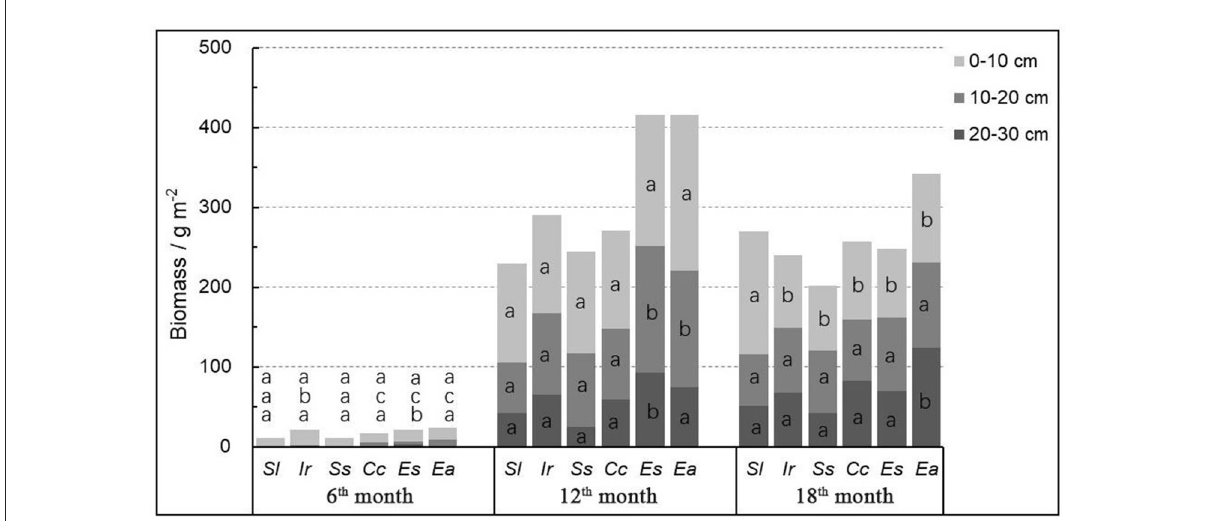
FIGURE4 Vertical development of fine root biomass (g m − 2 ) of all the six tree species from the 6 to 18th month since plantation. The abbreviations of Sl , Ir , Ss , Cc , Es , and Ea were short for Sterculia lanceolata , Ilex rotunda , Schima superba , Cinnamomum camphora , Elaeocarpus sylvestris , and Elaeocarpus apiculatus . The light gray, medium gray, and black bars represent the fine roots in the soil layer of 0–10cm (shallow layer), 10–20cm (middle layer), and 20–30cm (deep layer), respectively. The letters “a”, “b”, and “c” indicate significant differences ( P < 0.05) between fine root biomass of different tree species in the same month.